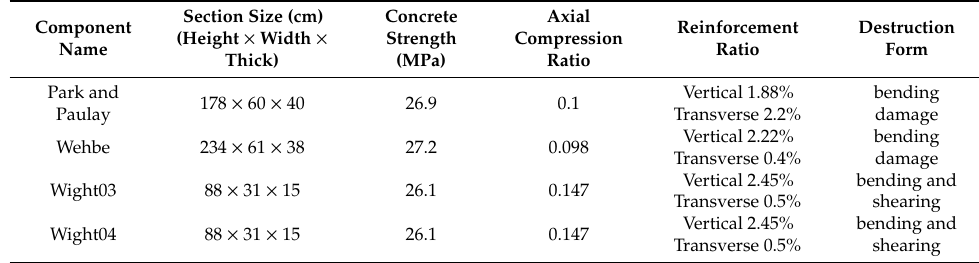
Table 2. Parameters of column